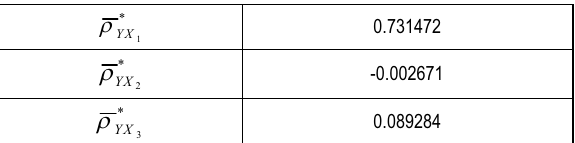
Table 2. The values of the partial correlation coefficients between indices of funding of